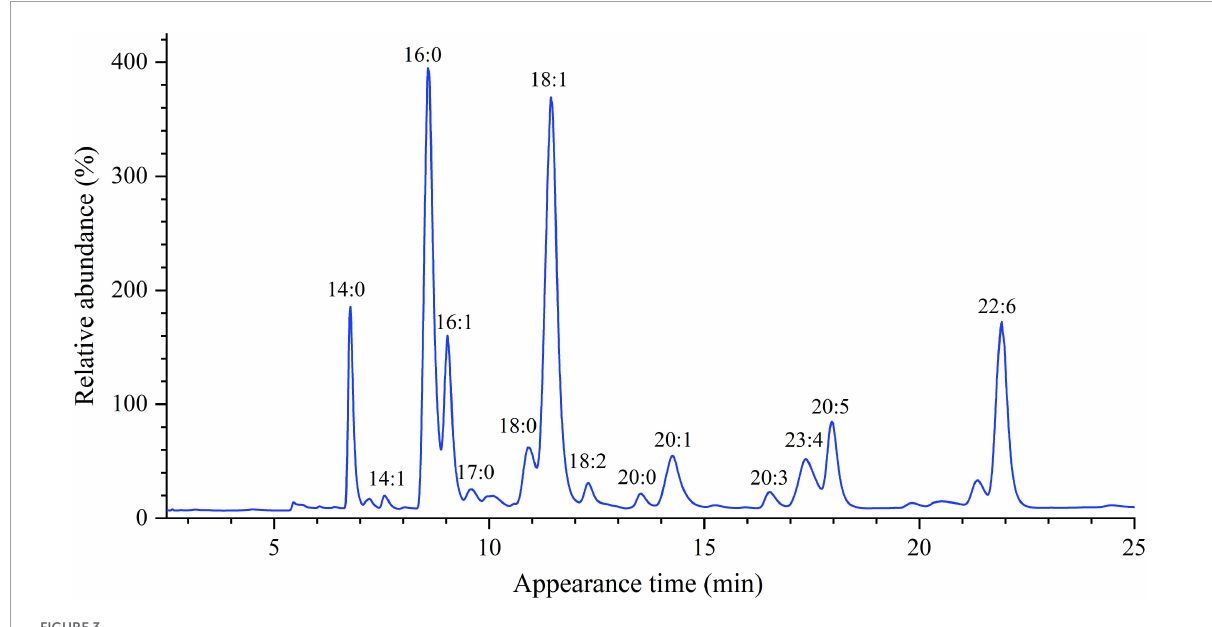
FIGURE3 The representative GC chromatogram of hairtail muscle fatty